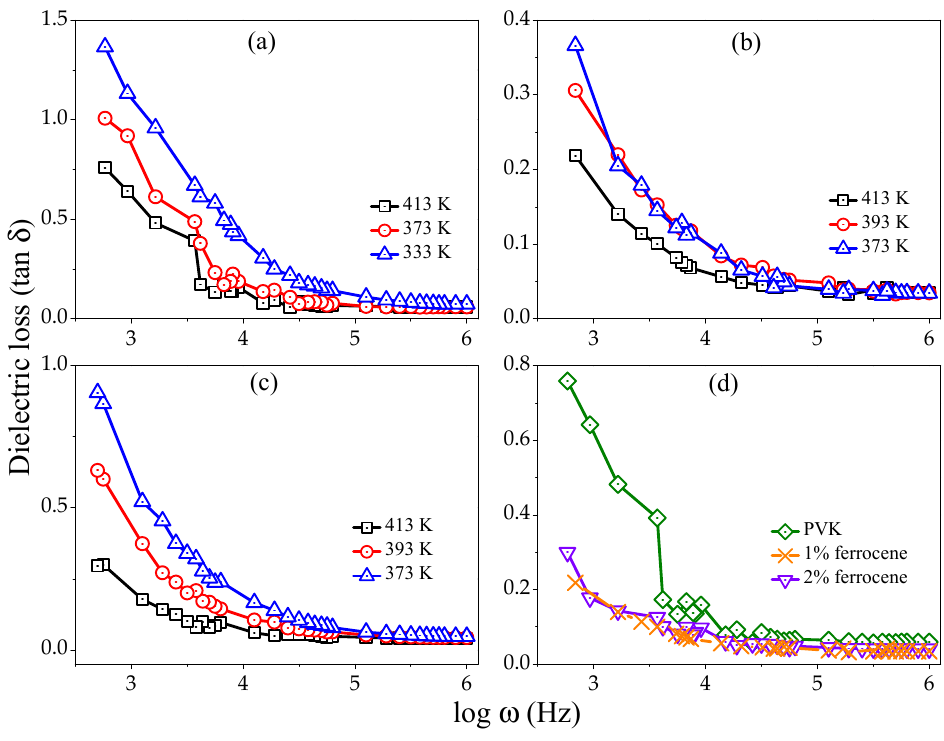
Figure 4. Variation of real part of loss tangent (tan δ ) as function of frequency for ( a ) pure PVK, ( b ) 1% ferrocene doped PVK, ( c ) 2% ferrocene doped PVK, and ( d ) at 413 K for pure and doped PVK. It is observed that the tanδ decreases exponentially with the frequency upsurge for all studied temperatures. It can be seen from figures that the tanδ values are larger at higher temperatures in the low frequency region. However, the tanδ values at different temperatures are almost similar in the high frequency region. These figures are also rep- resenting frequency dominant relaxation. Figure 4d shows that the comparison between tanδ values of PVK and ferrocene doped PVK thin films.